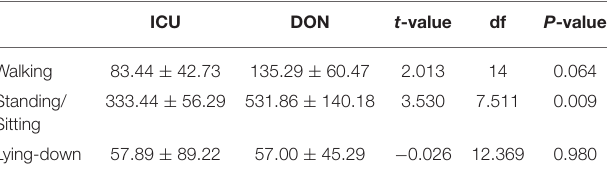
TABLE 5 | Posture differences in ICU and DON departments ( n = 16).